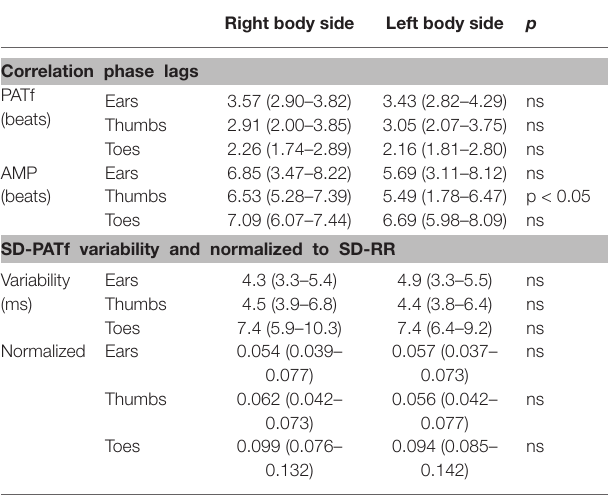
TABLE 1 | Summary of PATf and AMP cross correlation phase lag data (in heartbeats) and also normalized variability data for the 0.1 Hz paced breathing